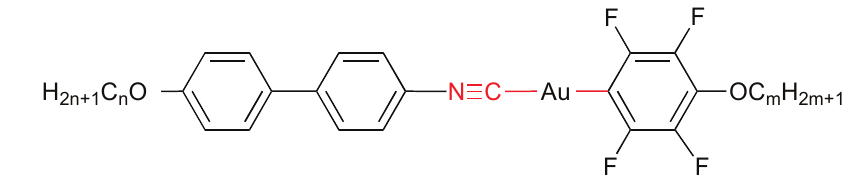
Figure 14. Isocyanide and perfluoroaryl gold mesogen. n = 10 and m = 6; n = 6 and m = 10.